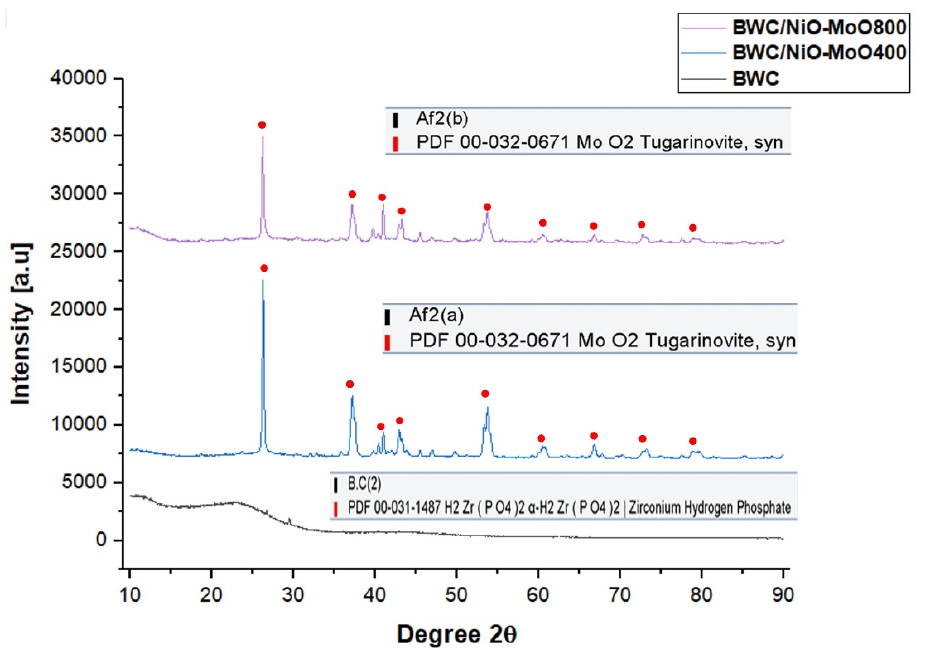
Figure 3. XRD diffraction of before and after calcined woodchip biochar catalyst incorporated with NiO-MoO/BWC.